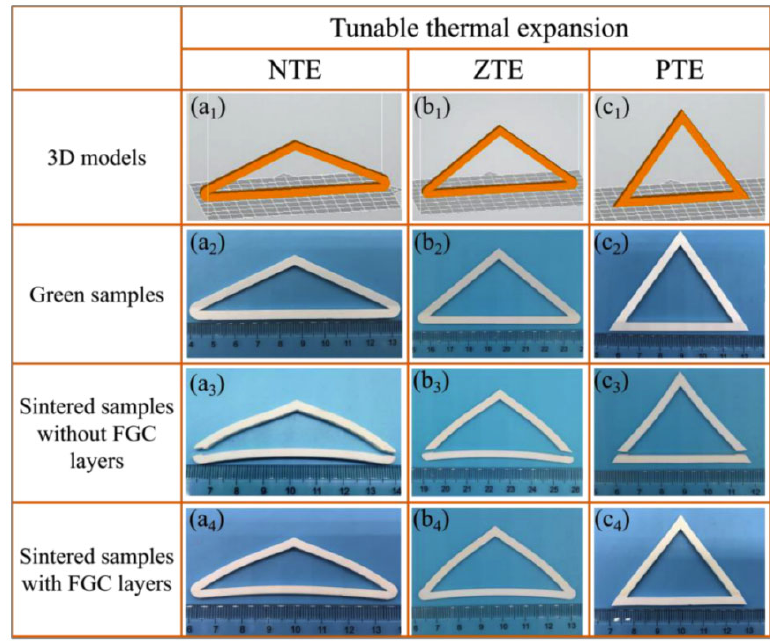
Fig. 48 3D models, green samples, sintered samples without FGC layers, and sintered samples with FGC layers of the multi-ceramic structures: (a 1 –a 4 ) negative thermal expansion, (b 1 –b 4 ) zero thermal expansion, and (c 1 –c 4 ) positive thermal expansion. Reproduced with permission from Ref. [134], © Elsevier Ltd.